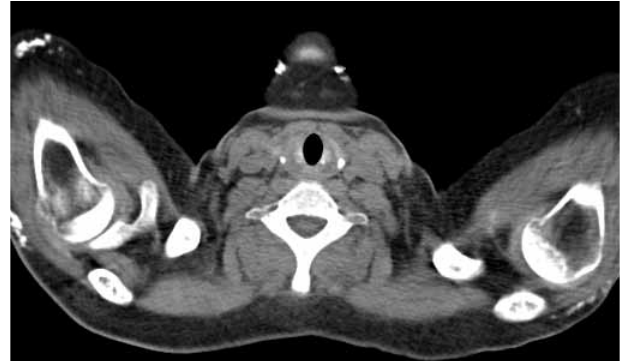
Fig. 3. Axial CT scan at the level of the shoulders demonstrates soft-tissue calcifications in the subcutaneous tissue around the shoulders.